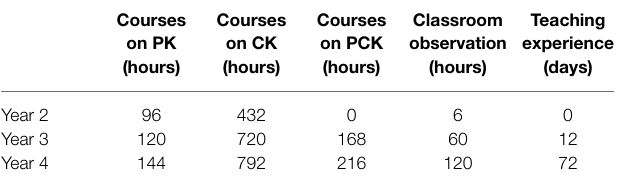
TABLE 4 | Number of learning opportunities concerning PCK, PK, and CK. Courses on PK